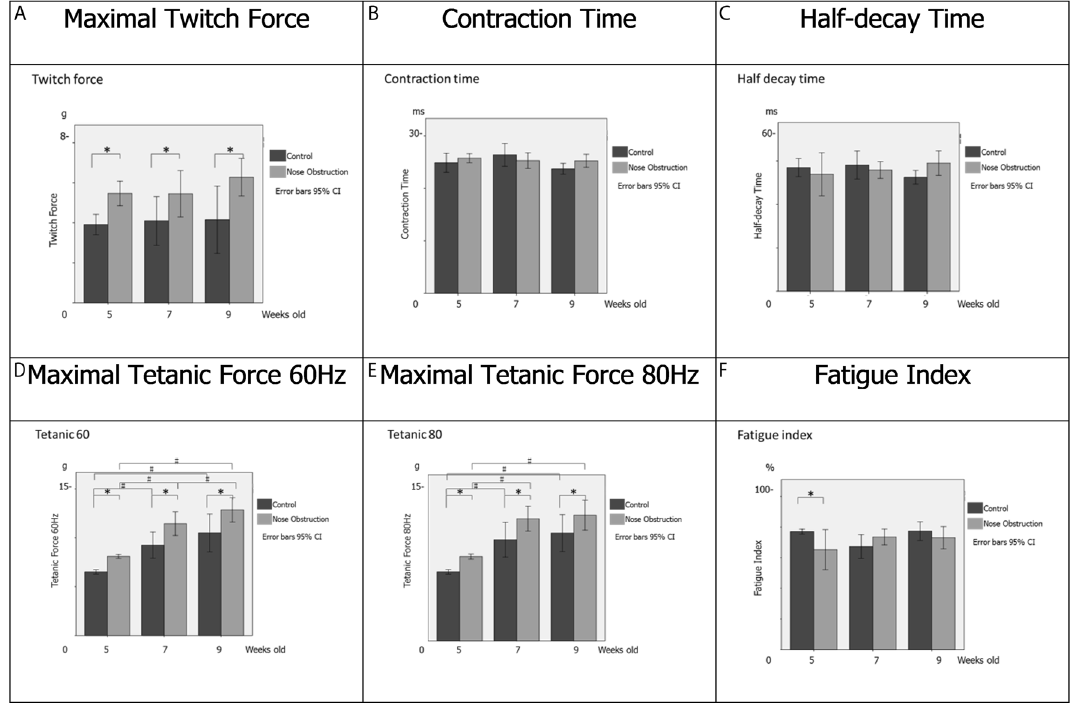
Figure 2. Contractile properties of Genioglossus muscle. ( A ) Maximal twitch force in grams (g) at 5, 7 and 9 weeks old. ( B ) Contraction time at 5, 7 and 9 weeks old. ( C ) Half-decay time at 5, 7 and 9 weeks old. ( D ) Tetanic force at 60 Hz at 5, 7 and 9 weeks old. ( E ) Tetanic force at 80 Hz at 5, 7 and 9 weeks old. ( F ) Fatigue index at 5, 7 and 9 weeks old. Bars in black, Control group; bars in grey, nose obstruction group. The x-axis shows the age of the rats, the y-axis shows the contractile properties measurements, for both control and nose obstruction groups. A repeated-measures multivariate analysis of variance was performed for intergroup and intragroup statistical comparisons. A simple main-effects analysis with Sidak adjustment was performed for multiple comparisons. Data are expressed as mean ± standard deviation. * ,# P < 0.05. Error bars at 95% confidence interval. 5 5 weeks old, 7 7 weeks old, 9 9 weeks old, g grams, ms millisecond, %